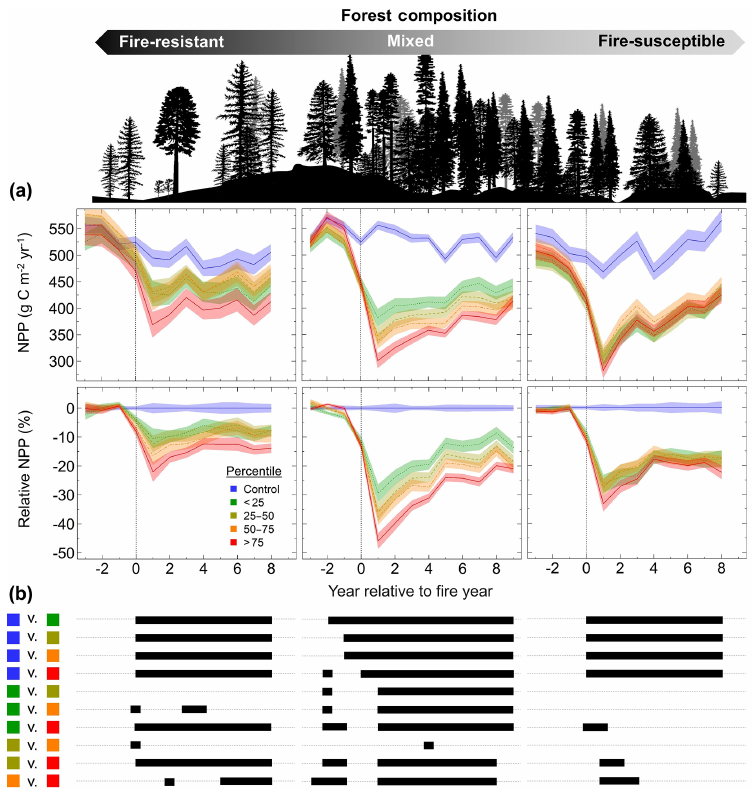
Figure 4. Fire intensity impacts on net primary productivity. (a) FRE dose impacts on absolute NPP (gCm − 2 yr − 1 ) and relative NPP (%) observed in forests dominated by species varying from fire-resistant to fire-susceptible (first column–third column). NPP is grouped by FRE percentile classes and shading represents 95% confidence intervals in all panes. Gray dotted line marks fire year. (b) Results from ANOVA with a post hoc Tukey’s honest significant difference test ( α = 0 . 05). Black bars indicate years where relative NPP groups